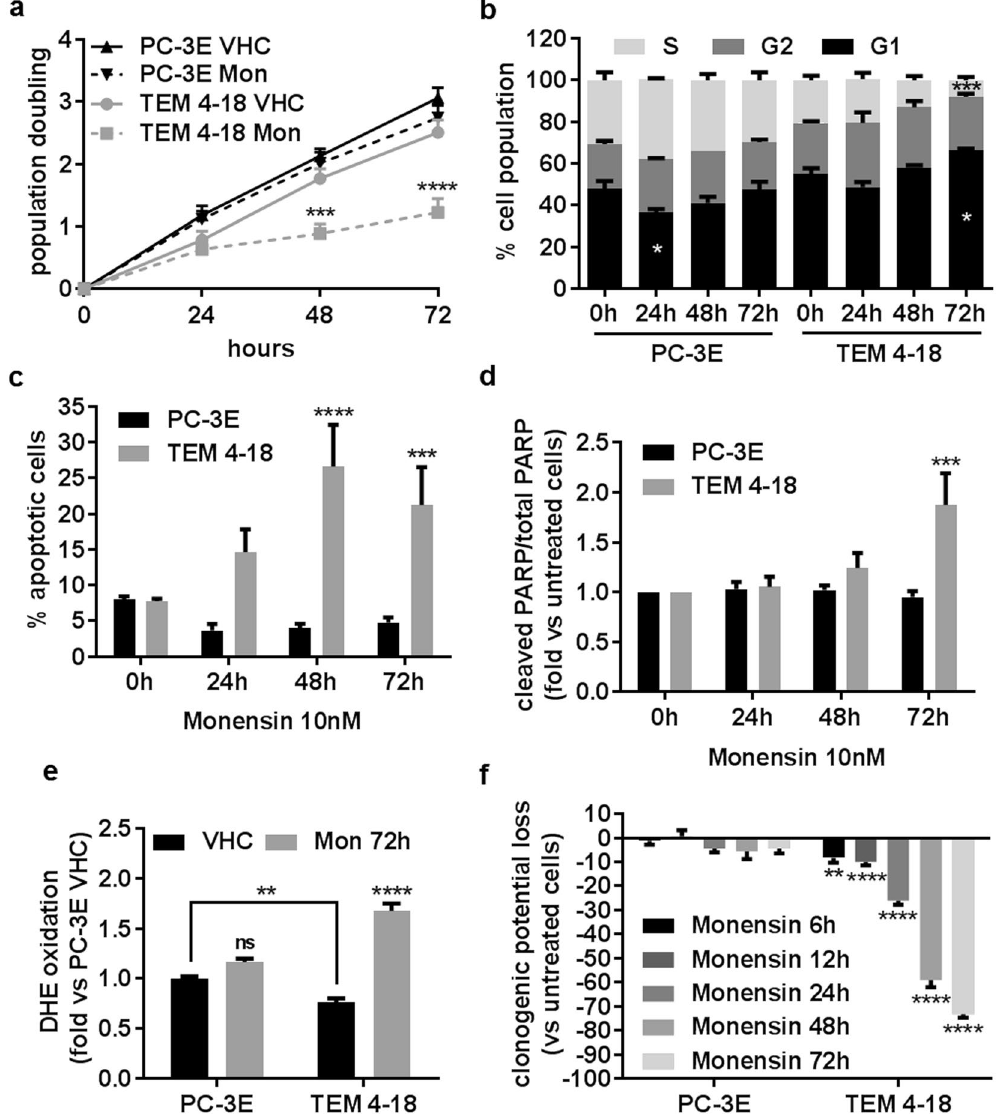
Figure 2. Monensin induces oxidative stress, apoptosis and a cell cycle arrest in TEM 4-18 cells. PC-3E and TEM 4-18 cells were treated with monensin (10 nM) for up to 72 h. Every 24 h, ( a ) the number of population doubling (n = 6), ( b ) cell cycle progression (PI incorporation) (n = 3), ( c , d ) apoptosis induction (C: Annexin V staining (n ≥ 3); D: PARP cleavage (n = 4)), ( e ) ROS formation (DHE probe oxidation) (n ≥ 7), and ( f ) clonogenic potential (n ≥ 12) were evaluated. Data represent mean values ± SEM. * p < 0.05, ** p < 0.01, *** p < 0.005, **** p <